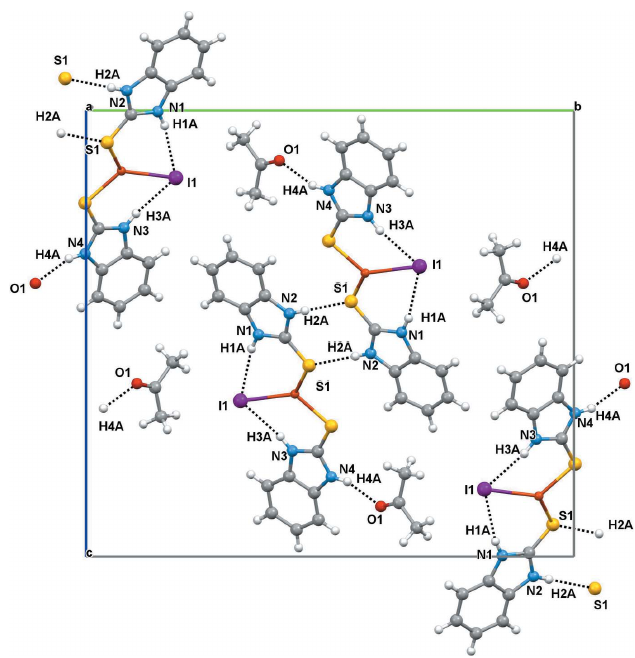
Figure 3 The intra- and inter molecular hydrogen-bonding interactions of ( 2 ).